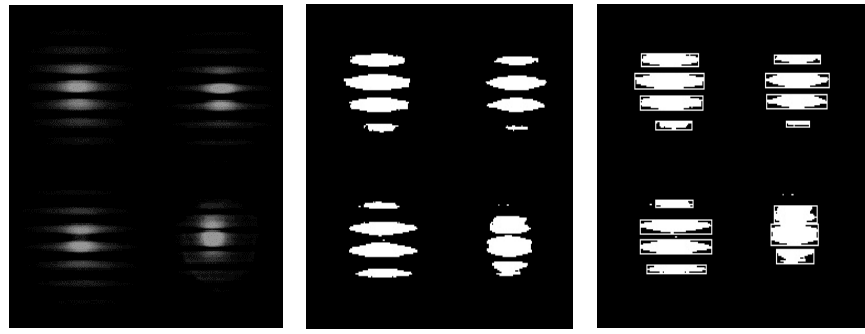
Figure 3. Three phases of fringe signal processing (Dibbiny and Kays, 2017).